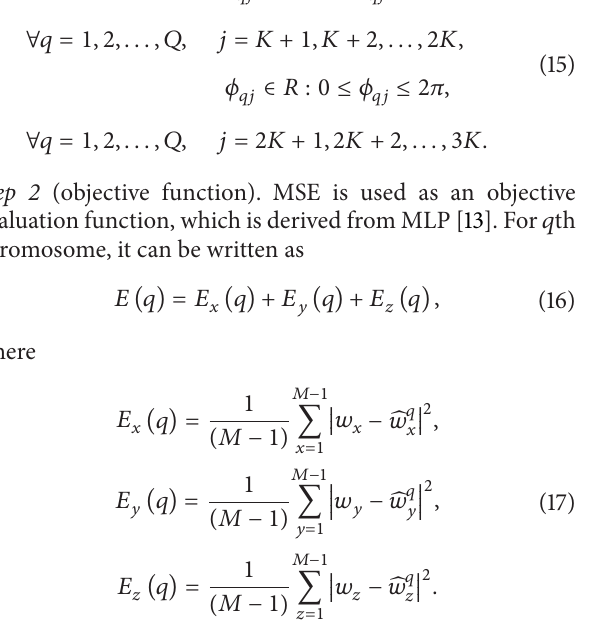
is repeated. It has already got application almost in every field such as signal processing and soft computing